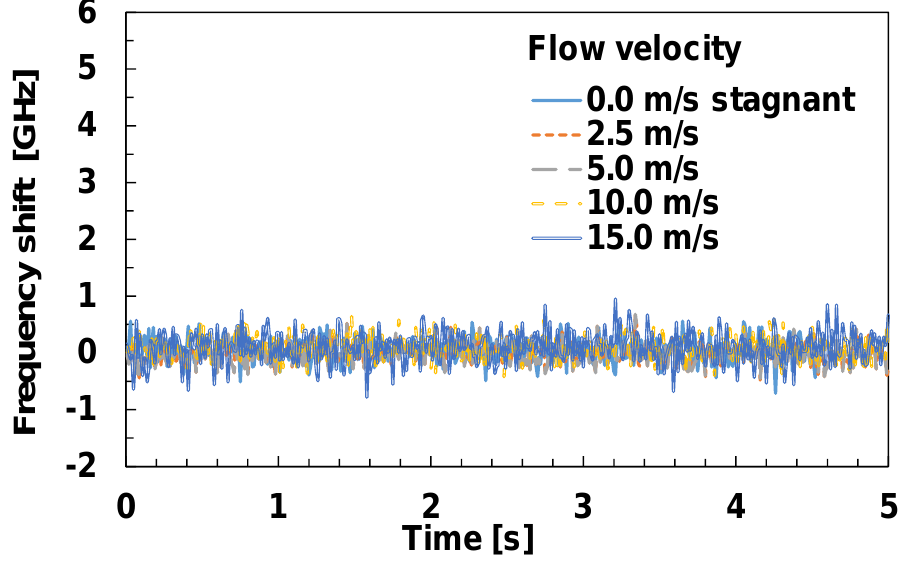
Figure 8. Effects of wind velocity on the frequency shift.